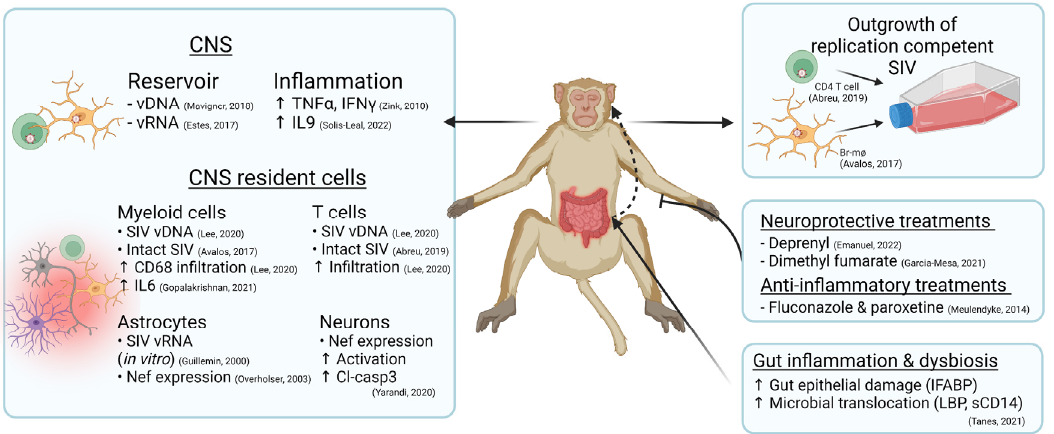
Figure 1. Potential mechanisms driving SIV reservoirs (including replication-competent viruses) and immune dysfunction in the brain of SIV-infected non-human primates. If left untreated, SIV infection in the CNS results in SIVE, which is characterized by multinucleated giant cells in the brain (i.e., the fusion of multiple cells), mediated by nef [84], neuronal damage, and ultimately death. Encephalitic lesions in the brain form CD163/68+ perivascular macrophages and the recruitment of microglia, CD4+ T cells